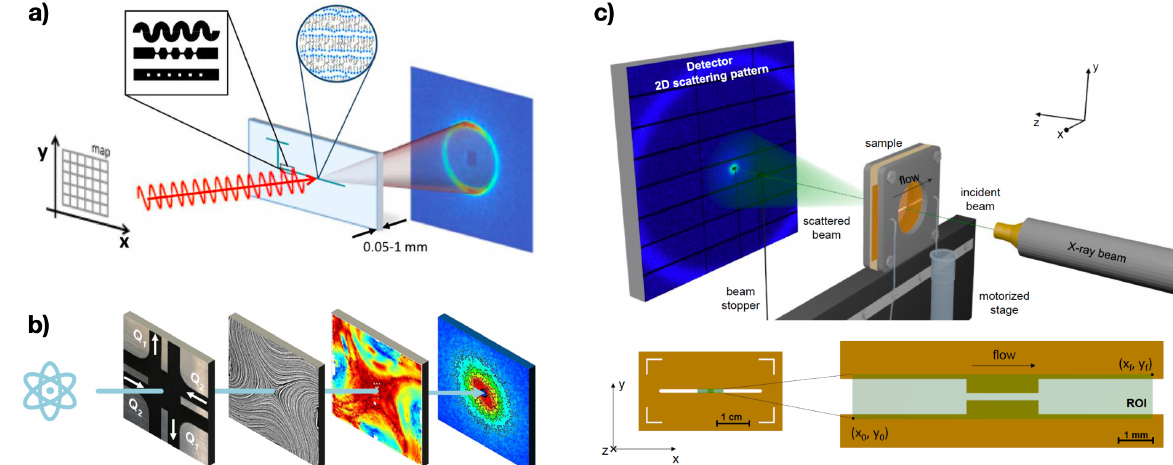
Figure 6. Examples of microfluidic rheometers integrated to Small Angle Neutron Scattering (SANS) and Small Angle X-ray Scattering (SAXS). ( a ) Schematic of SANS integrated to a microfluidic device. Reprinted from Reference [103]. ( b ) Schematic of SANS experiments performed on a four-mill microfluidic device. Reprinted from Reference [110]. ( c ) Schematic of a SAXS apparatus integrated to a microfluidic device. Reprinted with permission from Reference [111], with permission of The Royal Society of